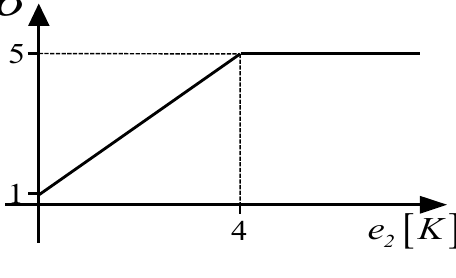
Figure 11. Regulation function of k 2 .